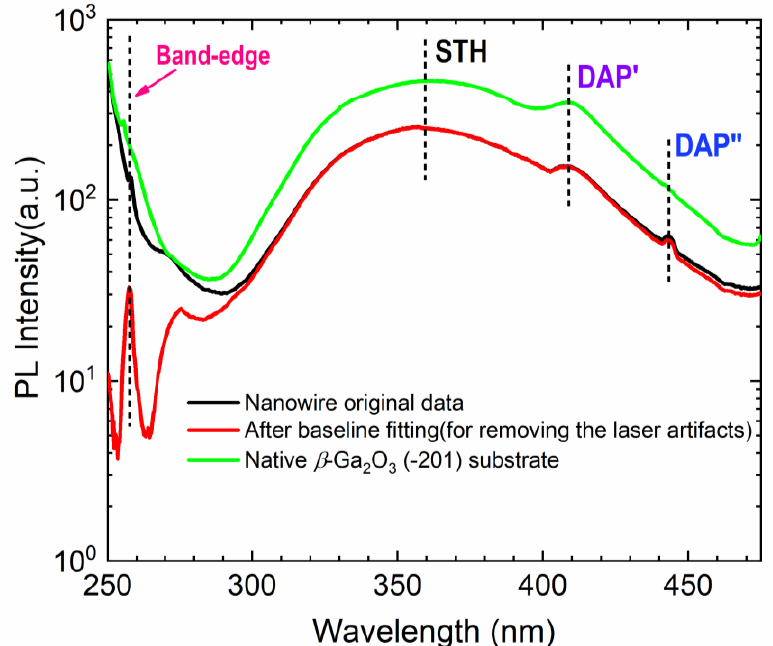
Figure 7. Room temperature photoluminescence (PL) spectra of β -Ga 2 O 3 nanowires and native β -Ga 2 O 3 substrate at the same optical excitation conditions.